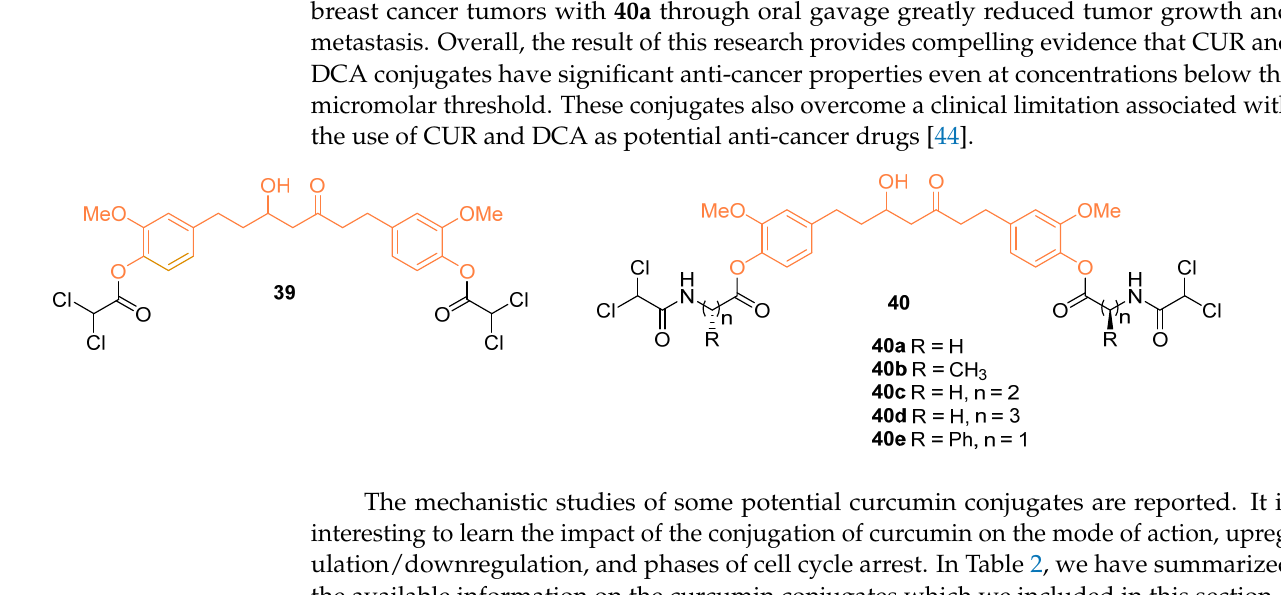
Table 2. Summarized information on curcumin conjugates.